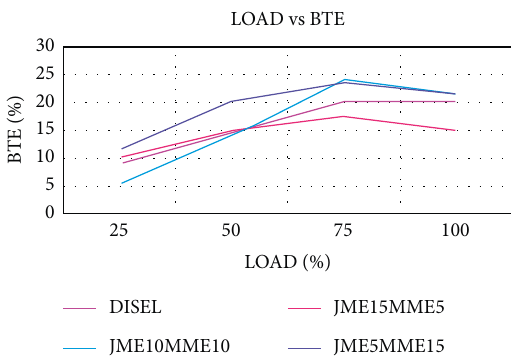
Figure 4: Variation of BTE with different